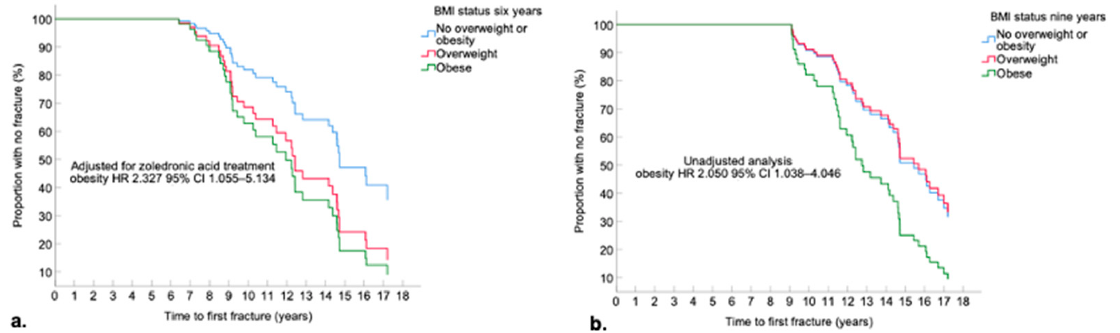
Figure 3. Kaplan-Meier Curve Time to First Fracture Stratified by BMI Status at Ages ( a ) Six Years ( b ) Nine Years.